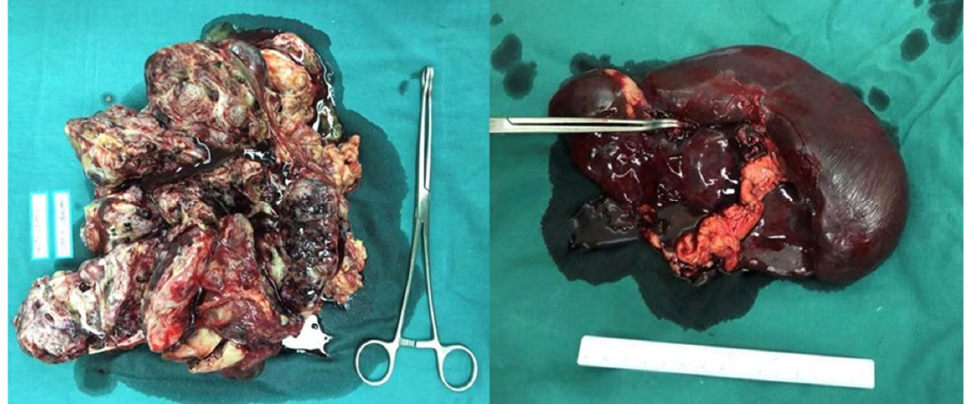
Figure 1. The mass located in the abdominopelvic cavity and the spleen.